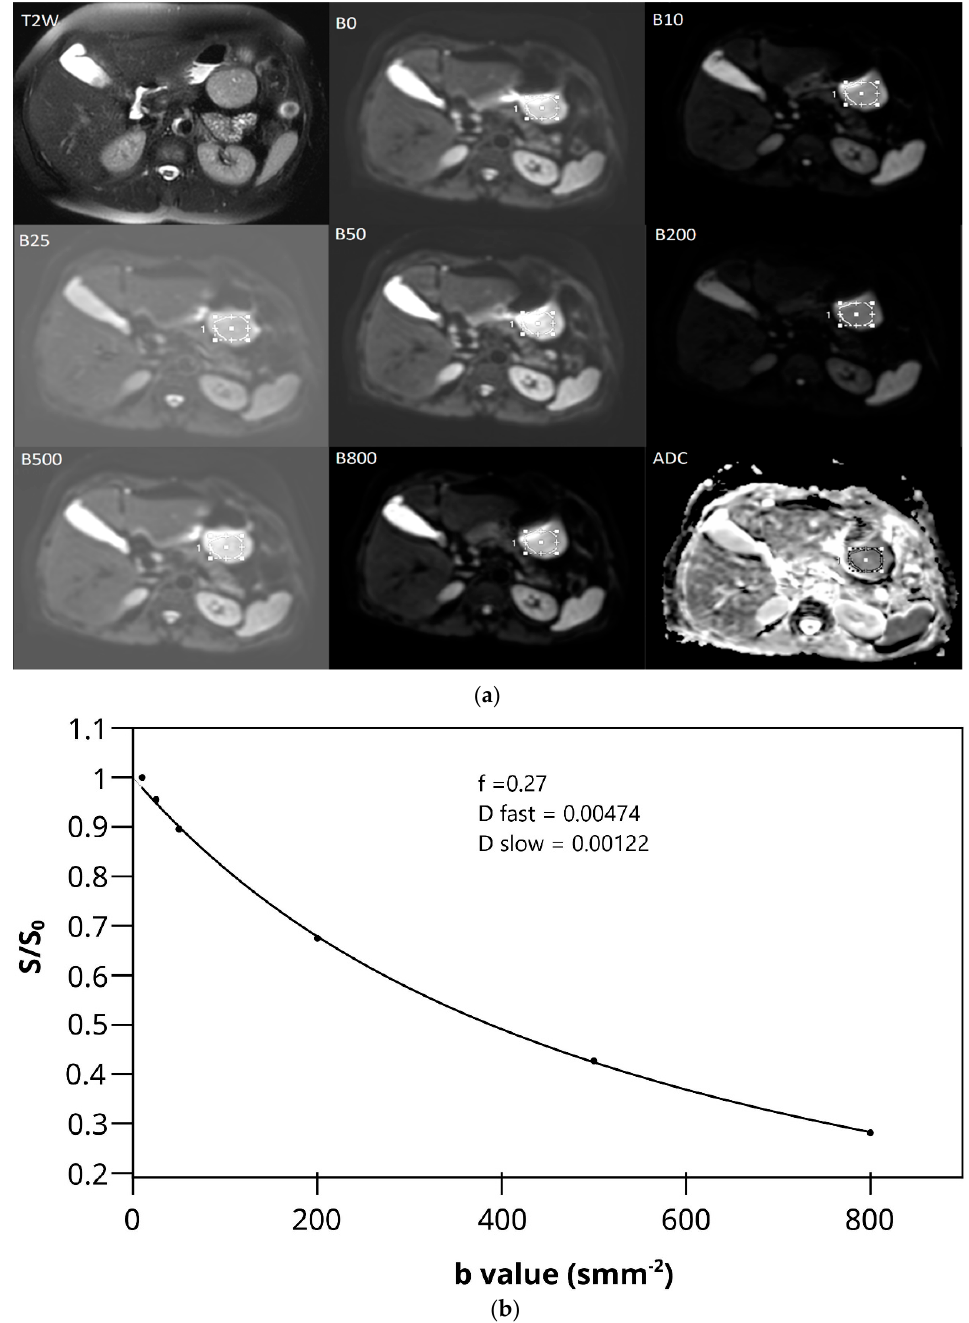
Figure 6. The averaged signal intensity decay and representative IVIM DW images. T2-weighted image in axial view is used for the precise localization of the tumor. DWI with multiple b-values and ROIs ( a ) followed by signal attenuation curve ( b ) where true diffusion coefficient (D slow), pseudo-diffusion coefficient (D fast) and perfusion fraction (f) were calculated based on the bi- exponential model.